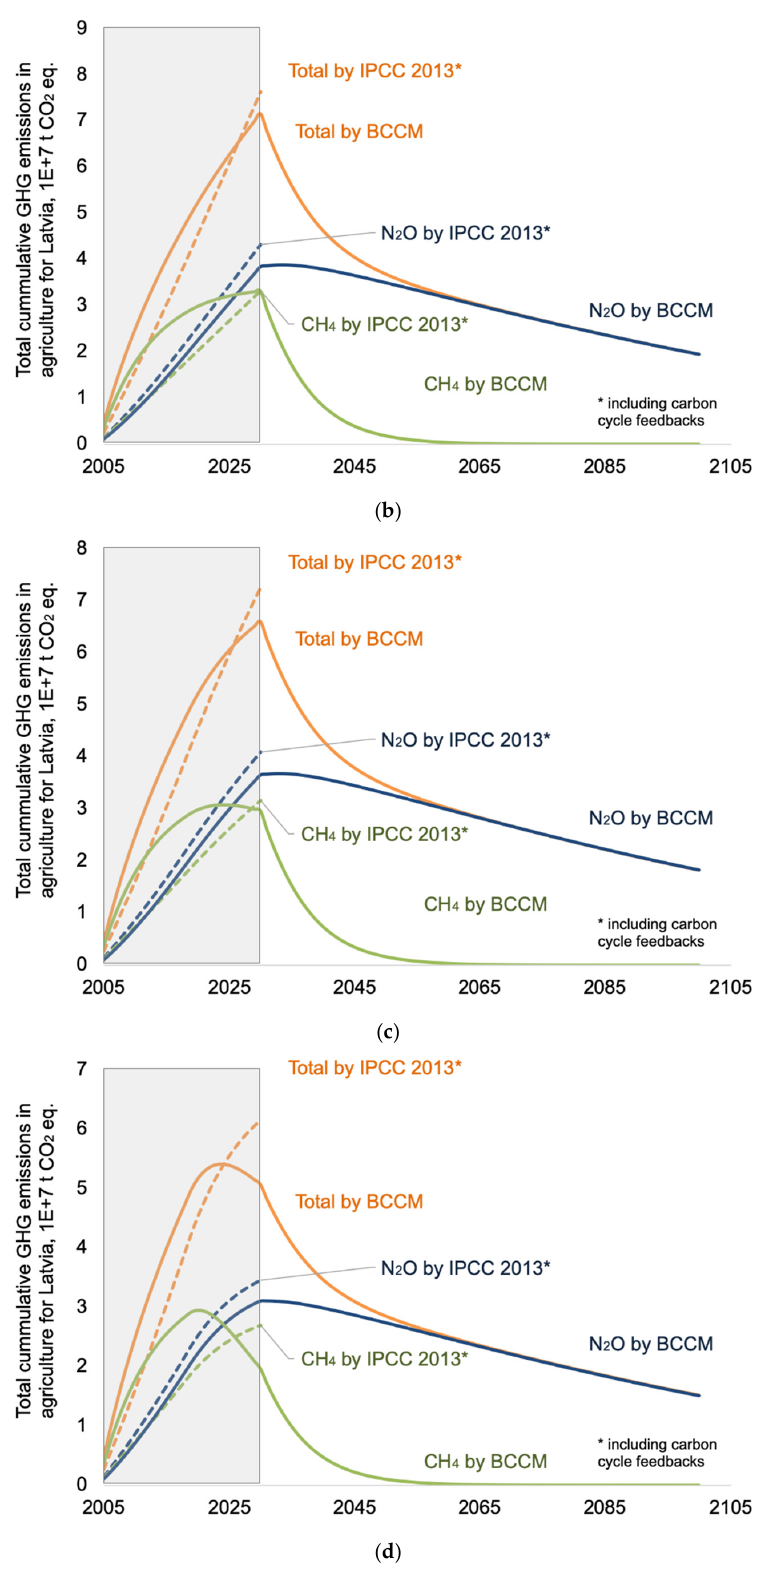
Figure 13. The comparison of the total cumulative GHG emissions calculated using IPCC methodology and decay function before and after year 2030, Latvia ( a ) reference case or business as usual based on Dace et al. [2] ( b ) constant emission after 2020, ( c ) declining emissions by 2% after 2020, ( d ) declining emissions by 10% after